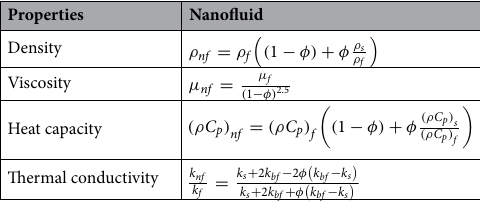
Table 1. Thermophysical properties of nanofluid 41 .